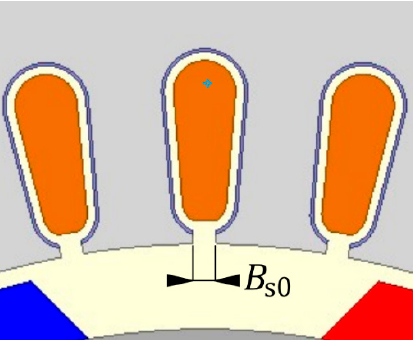
Figure 10. The shape of the analyzed stator slot with the marked opening width B s0 .